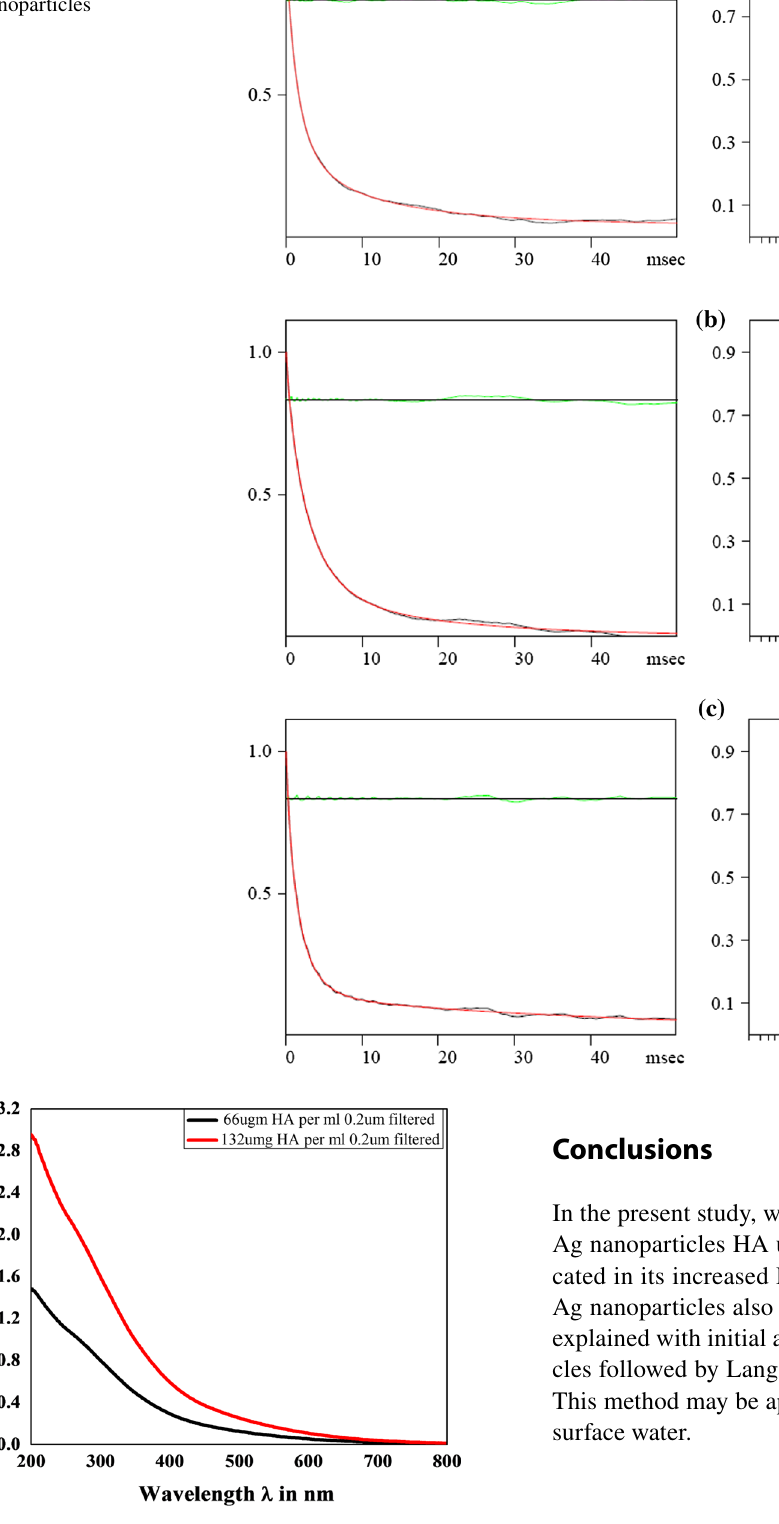
Fig. 4 DLS diameter of HA at different concentrations: a only HA, b 0.1% Ag nanoparticles, c